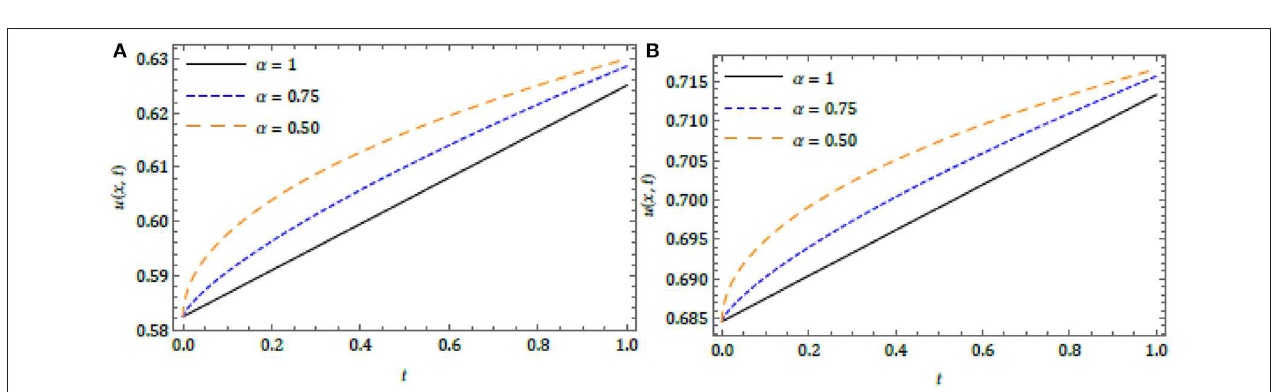
FIGURE 3 | Nature of the q -HATM solution for (A) Case 1 and (B) Case 2 with distinct α at ℏ = − 1, n = 1 and x = 1.